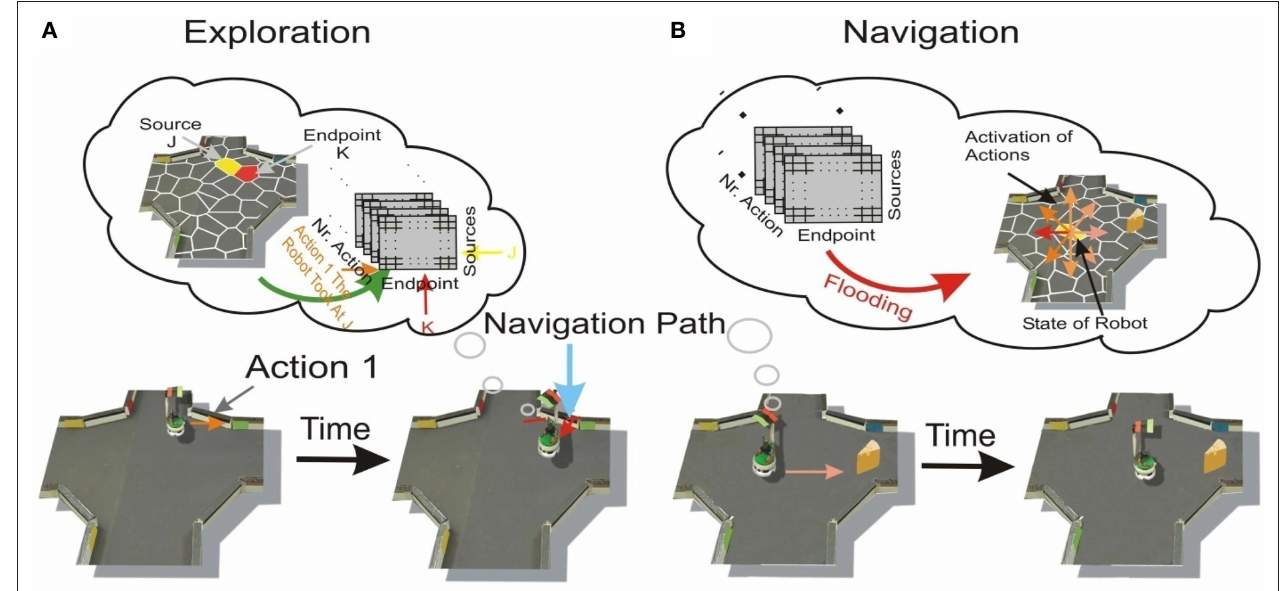
Figure  | (A) Learning of the properties of the environment. The robot is on a certain state, defined here as Source J (yellow labeled) and randomly chooses an action (Action 1). The execution of the action results in another state, defined as endstate K (red labeled). This transition was stored in a 3D matrix, called the experience matrix, with the dimensions sources, endpoints and actions. The